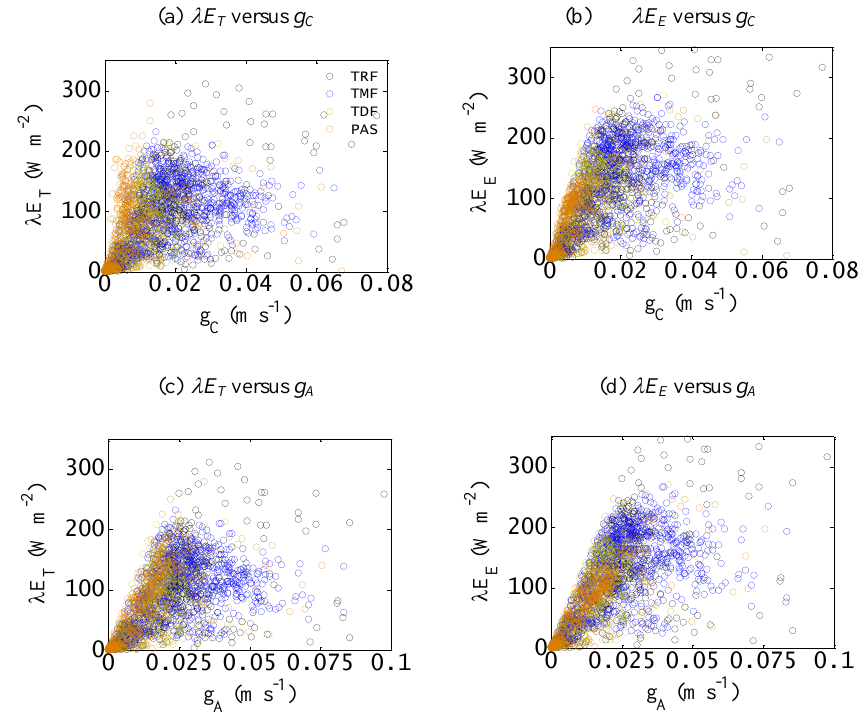
Figure 6. Scatter plots of transpiration ( λE T ) and evaporation ( λE E ) vs. g C and g A over four different PFTs in the Amazon Basin (LBA tower